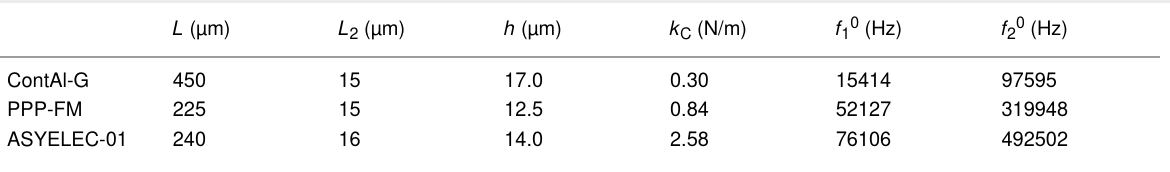
Table 1: Parameters of the experimental